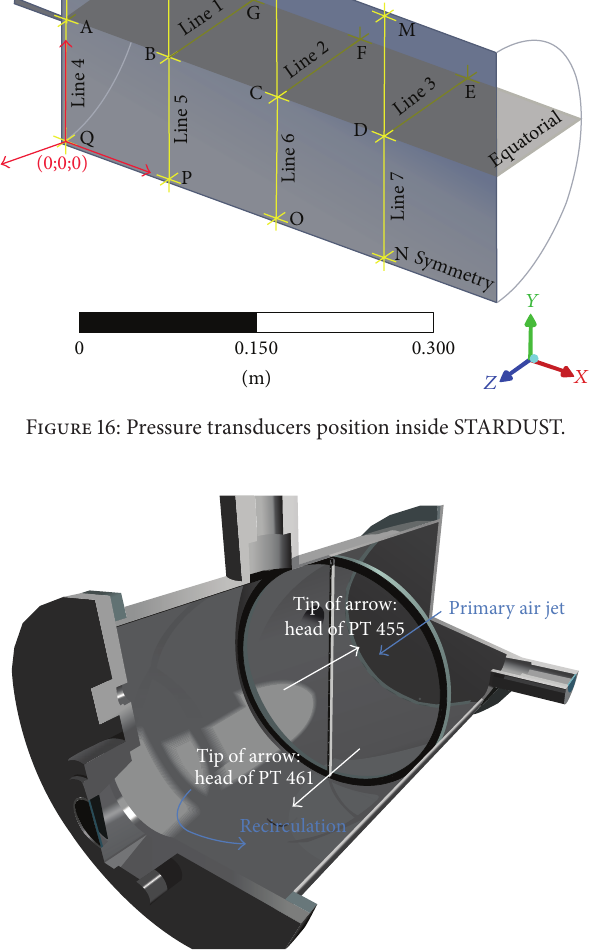
Figure 17: Pressure transducers